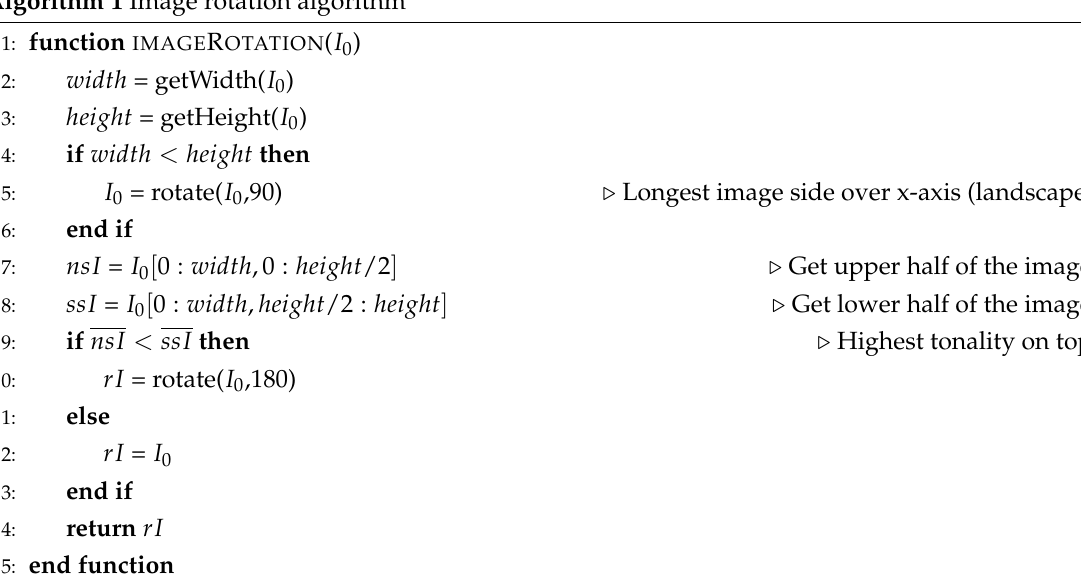
Algorithm 1 Image rotation algorithm